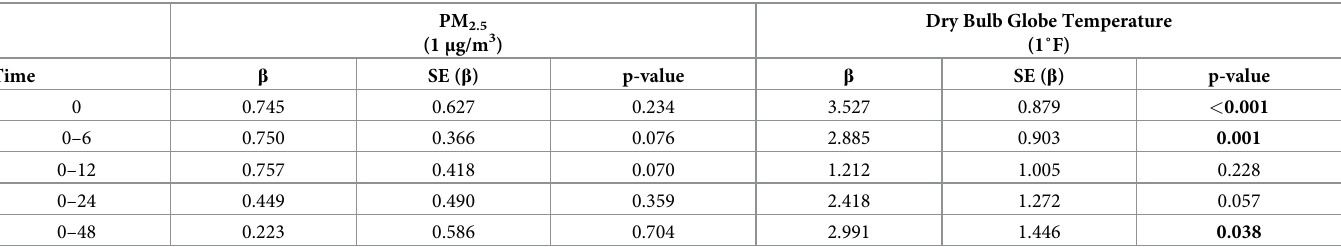
Table 4. Adjusted change in respiratory function per increase in PM 2.5 (1- μ g/m 3 ) and temperature (1˚F) in the same